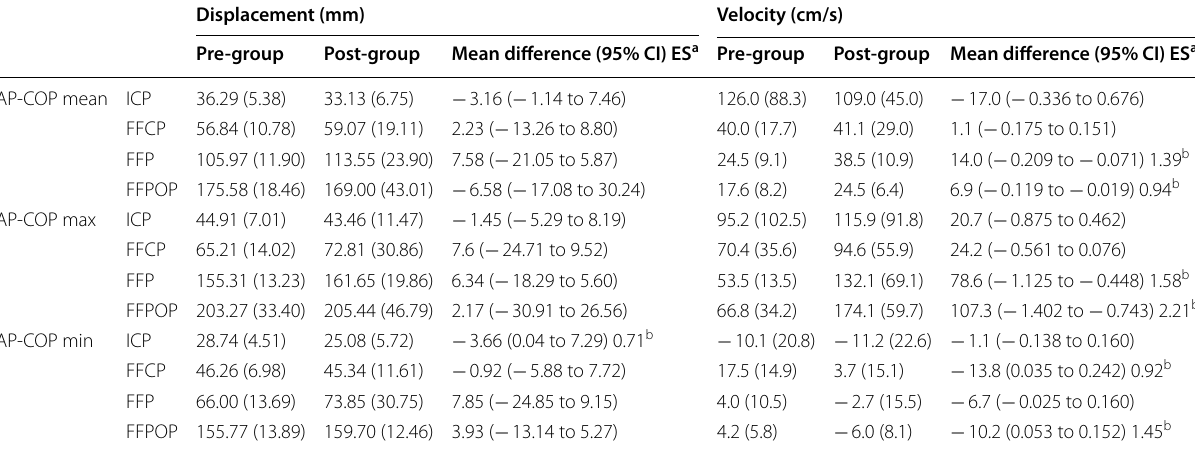
a ES: Effect size (Cohen’s d) only reported for statistically significant comparisons b Significant difference between groups, p <